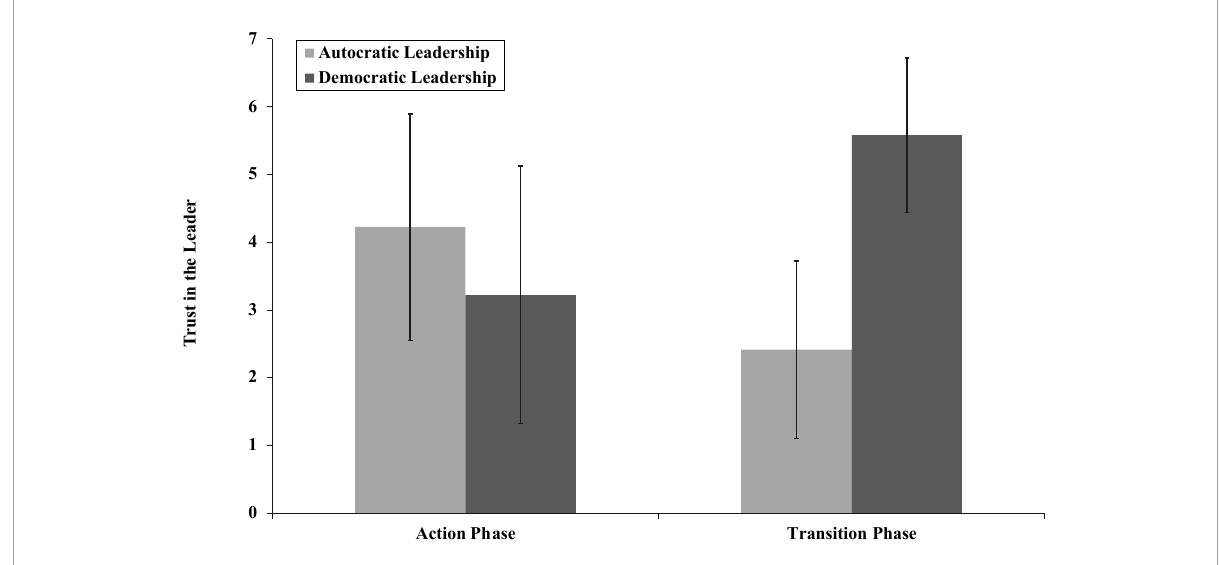
FIGURE2 The relationship between autocratic and democratic leadership and trust in the leader for the action and transition phase (Study